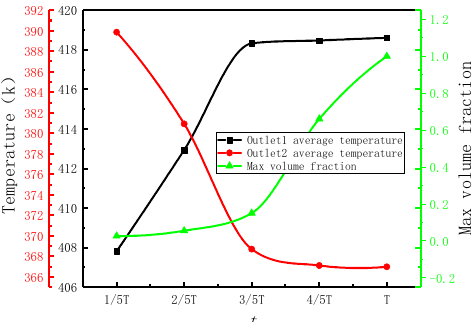
Figure 9. The curve of temperature at the outlet of hot and cold fluid and the vapor maximum volume fraction of wet saturated steam at the outlet changing with time.